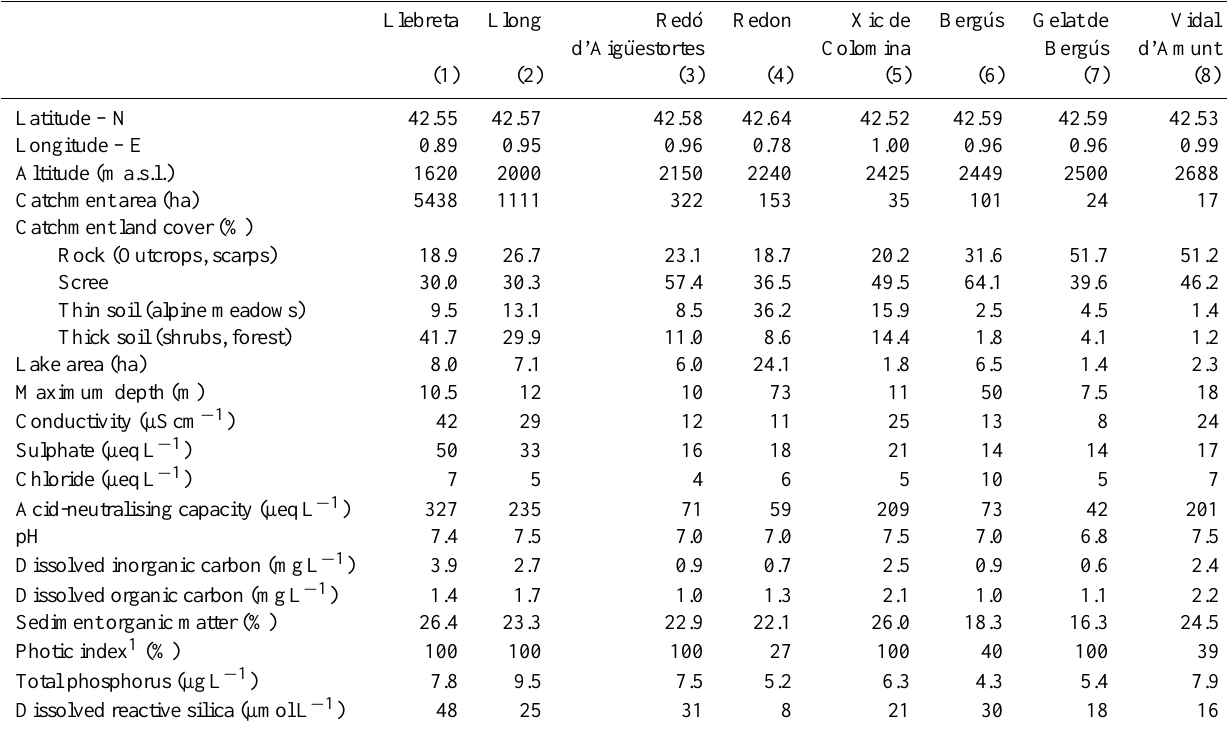
Table 1. Physical and epilimnetic chemical characteristics of the